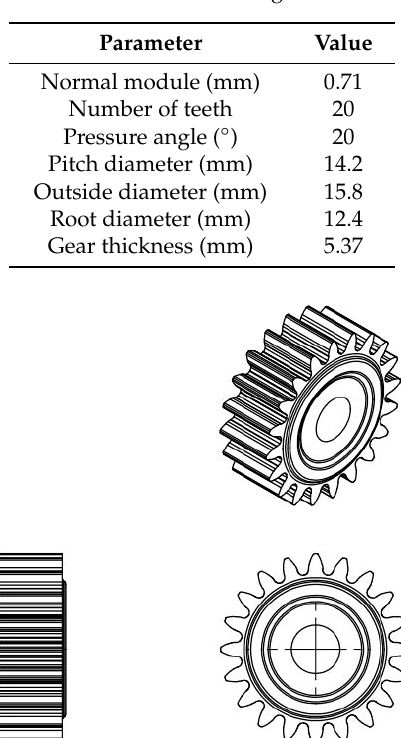
Table 1. Main geometrical data for the investigated small-module spur gears.